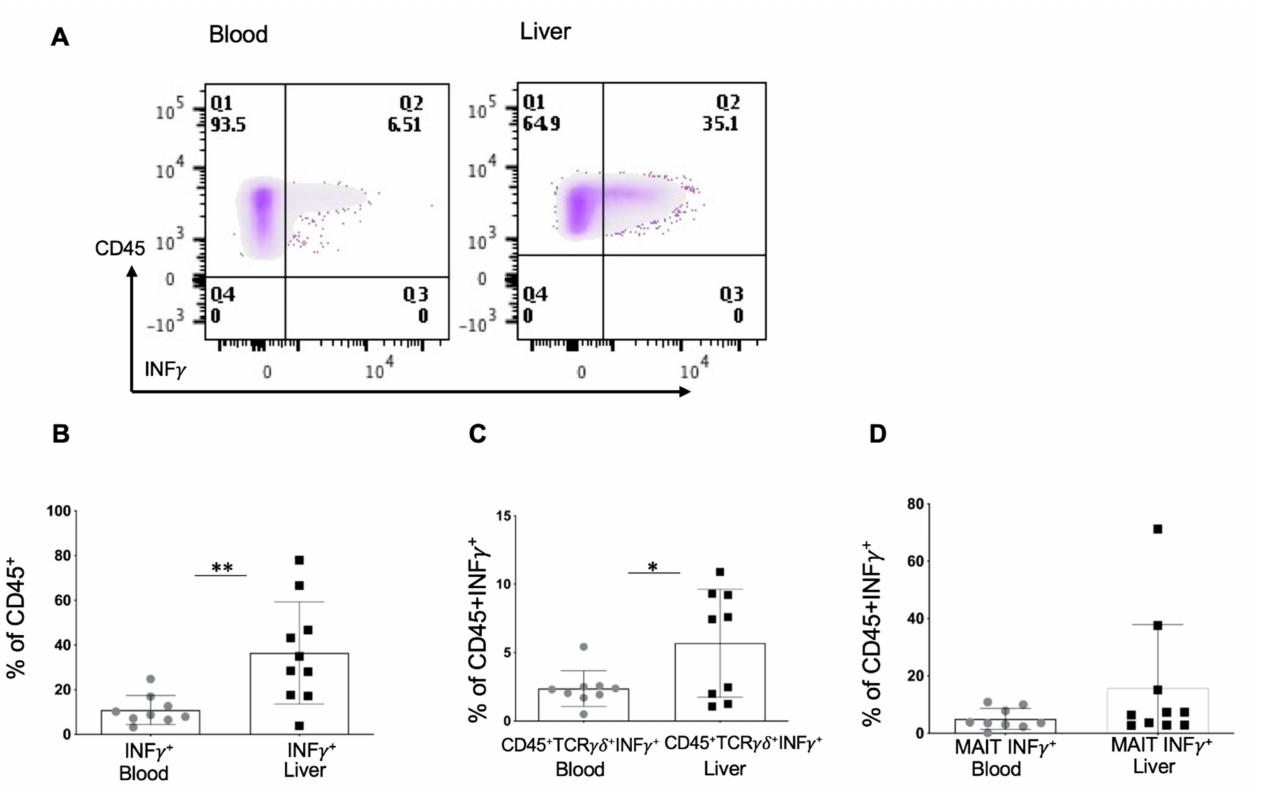
Figure 5. INF γ production in blood and liver samples by CD45 + lymphoid population. Representative plots ( A ) and graph ( B ) of lymphoid INF γ production in patients’ blood and liver (percentage (%) of CD45 + lymphoid population). ( C ) Percentage (%) of T γδ cells in CD45 + INF γ + lymphoid population in liver and blood. ( D ) Percentage (%) of MAIT cells in CD45 + INF γ + lymphoid cells in liver and blood (Mann–Whitney test, * p < 0.05, ** p <